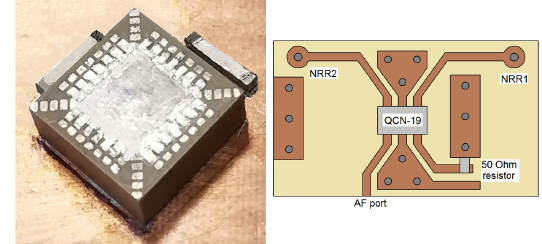
Fig. 9. AF sample: left – front side photo, right – QBPD circuit topology.